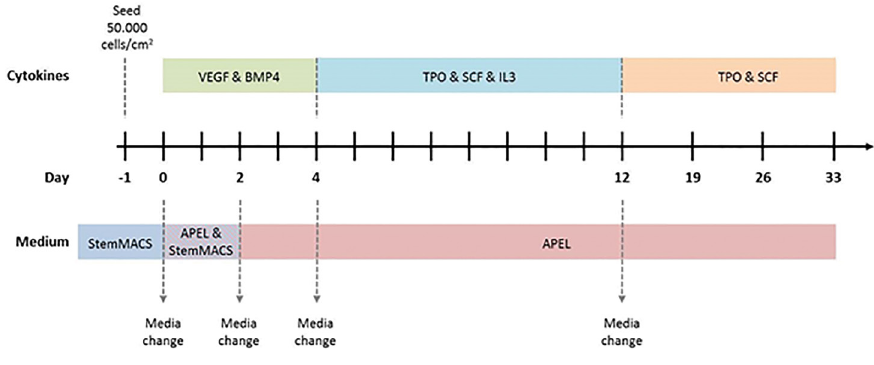
Figure 2. Schematic representation of the iPSC differentiation protocol toward megakaryocytes (MKs) and platelets (PLTs). iPSCs maintained in StemMACS medium were seeded at a density of 50,000 cells/cm 2 on Laminin-521-coated plates 1 d before starting the differentiation. From d 0 to 2, cells were cultured in ½ StemMACS medium and ½ APEL medium containing vascular endothelial growth factor (VEGF, 50 ng/mL) and bone morphogenetic protein 4 (BMP4, 50 ng/mL). On d 2, the medium was changed to APEL medium containing VEGF and BMP4 (50 ng/mL). Cytokines were changed from d 4 on to thrombopoietin (TPO, 50 ng/mL), stem cell factor (SCF, 50 ng/mL) and interleukin-3 (IL-3, 25 ng/mL). On d 12, the medium was changed to APEL medium containing TPO and SCF (50 ng/mL). Half of the medium was replaced twice a week. Dotted arrows indicate complete media changes due to modification in cytokine